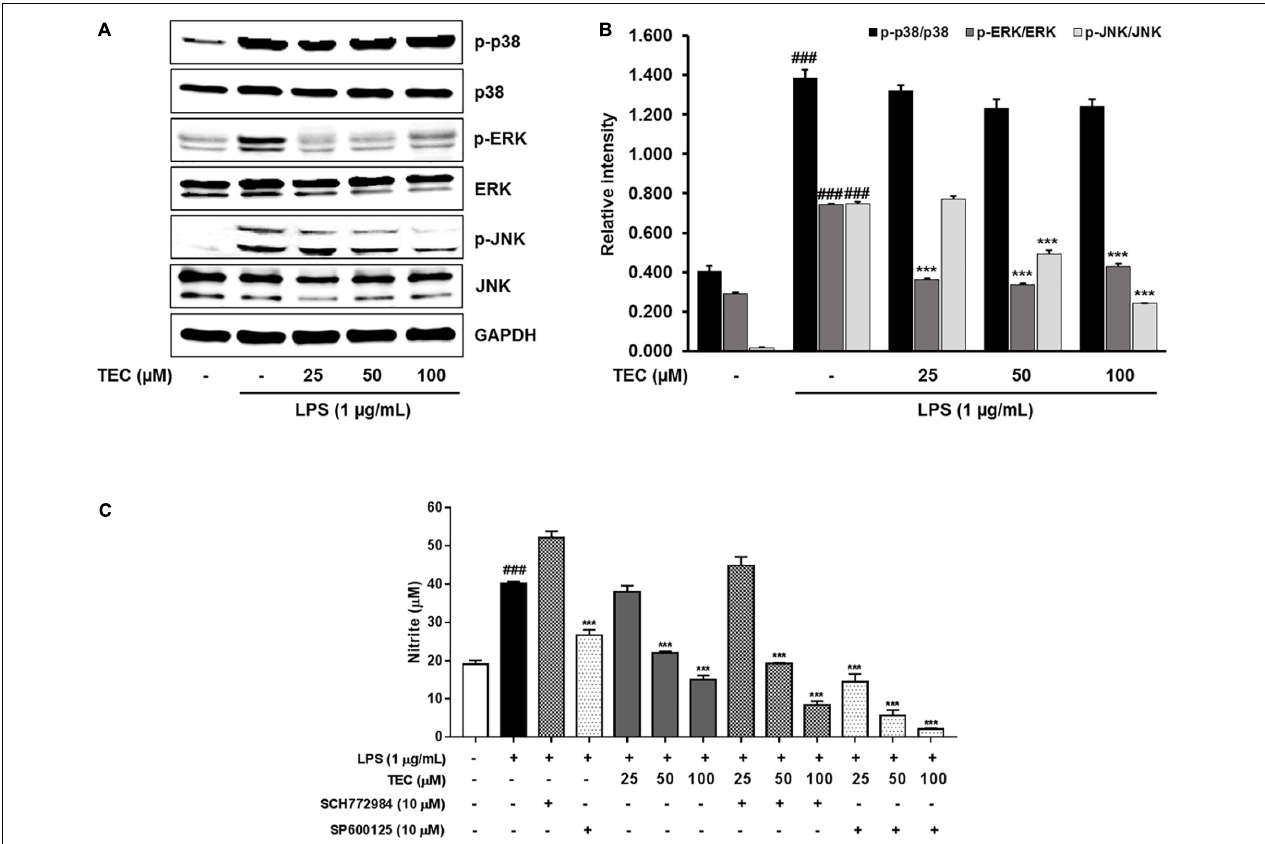
FIGURE 5 | TEC suppresses the phosphorylation of MAPKs in LPS-stimulated BV-2 microglia. Cells were pre-treated with TEC for 1 h followed by LPS stimulation (1 µ g/mL) for 30 min. (A) Western blot was performed to determine the effect of TEC on phosphorylation of MAPKs activity. (B) Bar graphs represent the relative expression of MAPKs phosphorylation for (A) . (C) Cells were pretreatment with TEC and inhibitors of p38 or JNK for 2 h and then stimulated with LPS (1 µ g/mL) for 22 h and then nitrite was measured by Griess reagents. The results are expressed as the mean ± SEM of three independent experiments. ### P < 0.001 vs. untreated control cells and ∗∗∗ P < 0.001 vs. LPS-treated